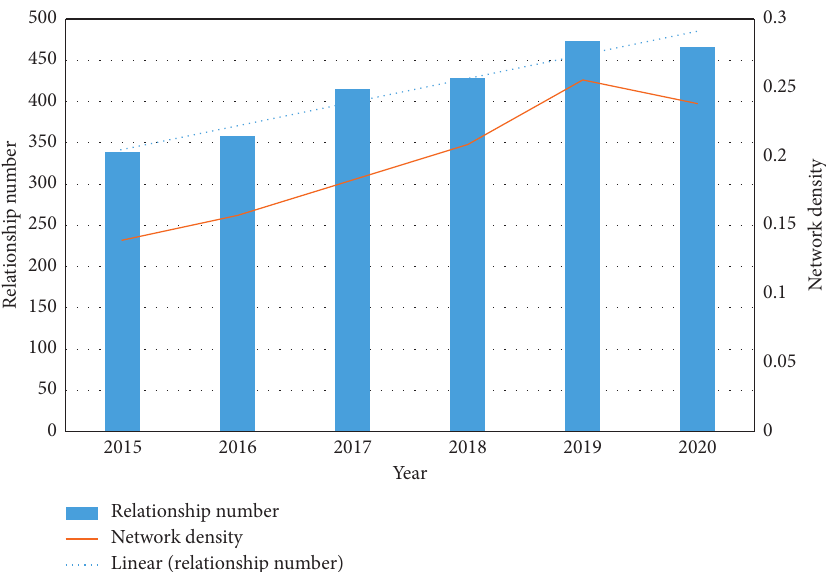
Figure 3: Network density and relationship